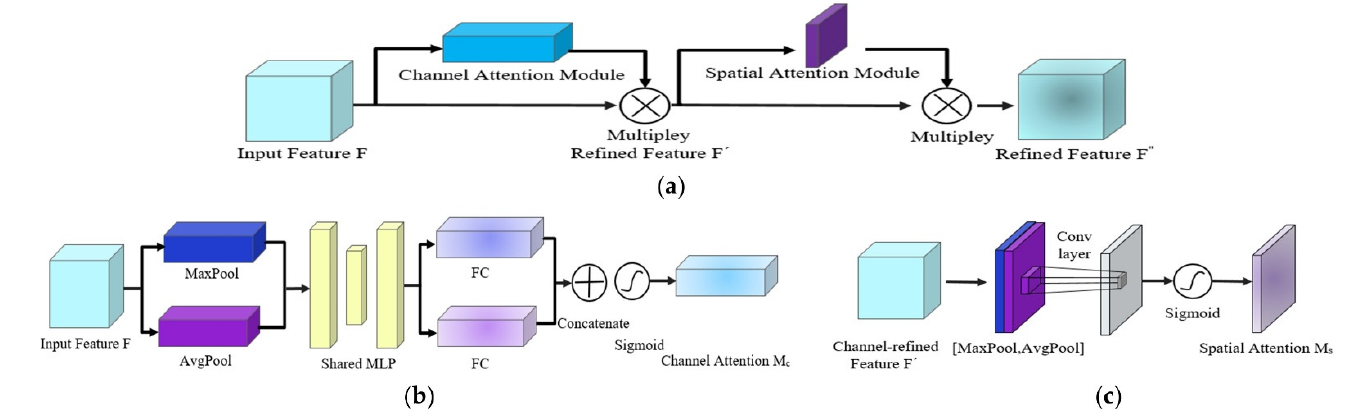
Figure 4. The structure of the attention block: ( a ) architecture of CBAM module; ( b ) architecture of channel attention module; ( c ) architecture of spatial attention module. MaxPool denotes max pooling layer; AvgPool denotes average pooling layer; MLP denotes a two-level fully connected layer; Sigmoid represents sigmoid activation function; Concatenate represents concatenate layer.